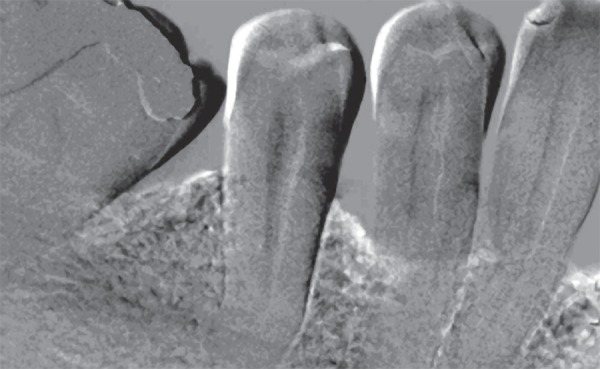
Subtraction radiograph showing a bone density gain on the mesial aspect of the
mandibular first molar and mandibular first premolar